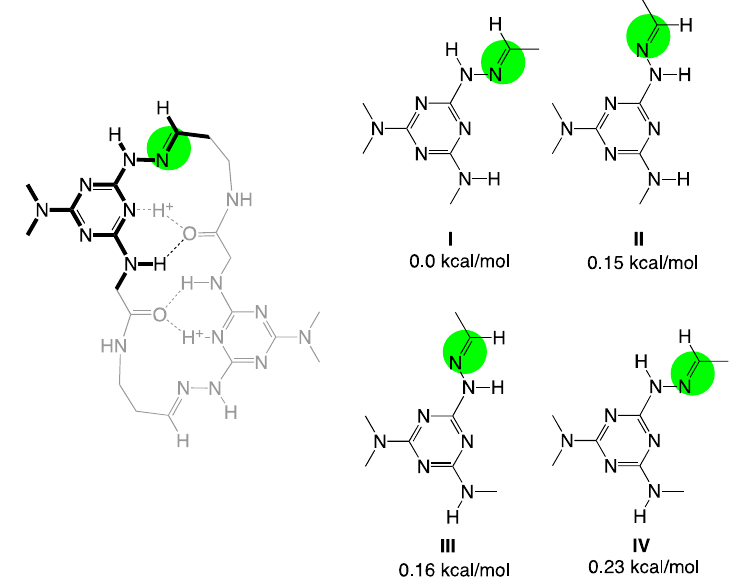
Figure 3. Calculations of the ground-state energies of different rotamers. Computational models revealed energetic preferences for specific rotamers upon protonation. To elaborate the models to account for protonation, isodesmic reactions were used, as illustrated in Scheme 2.